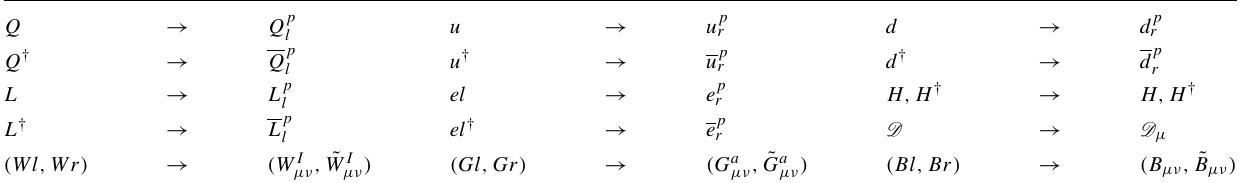
Table 21 Dictionary for translation of operators from the Hilbert Series output to their covariant forms. The translation from the form ( Fl , Fr ) to ( F μν , ˜ F μν ) is accomplished using Eq. (108) Q → Q p u → u p r d → d p r l Q † → Q p l u † → u p r d † → d p r L → L p el → e p r H , H † → H , H † l L † → L p l el † → e p r D